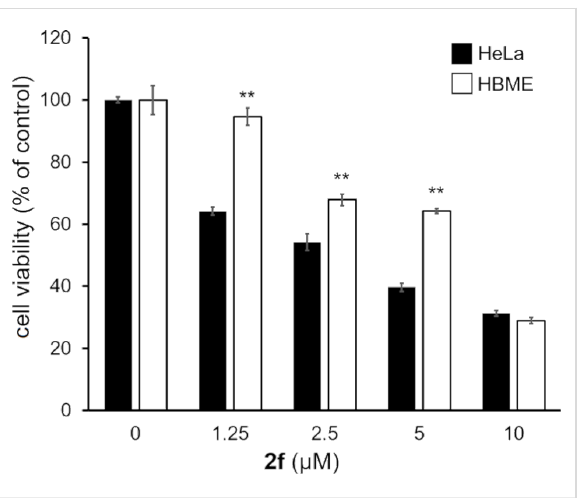
Figure 7: Cytotoxic effect of the bis[2-(4-methoxyphenyl)imidazo[1,2- a ]pyridin-3-yl] diselenide 2f on a cancer cell line and a noncancer cell line. HeLa cells and human brain microvascular endothelial (HBME) cells were exposed to compound 2f for 48 h. The cell viability was con- firmed by MTT assays. The data are represented as mean ± SD values of four samples. Statistical significance when compared to the corresponding HeLa cell group at each concentration point: ** p <